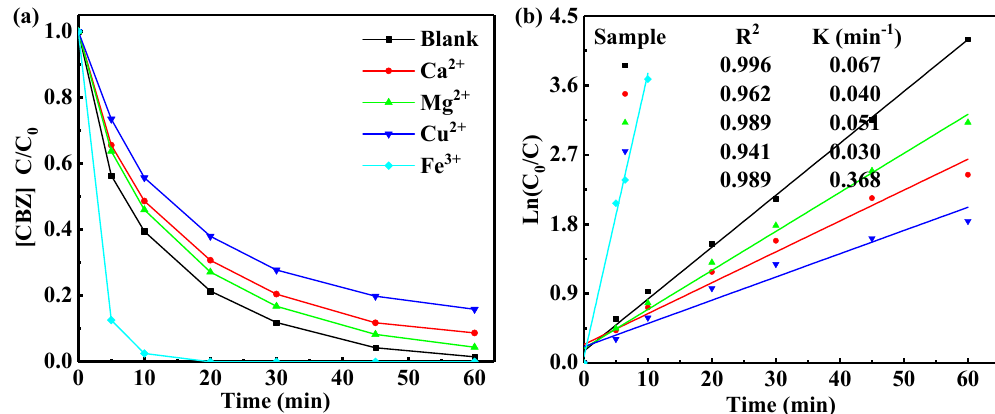
Figure 10. ( a ) Degradation of CBZ by UV-LED/TiO 2 with different co-existing cations. ( b ) The pseudo-first-order kinetic models of CBZ degradation by UV-LED/TiO 2 with different co-existing cations.